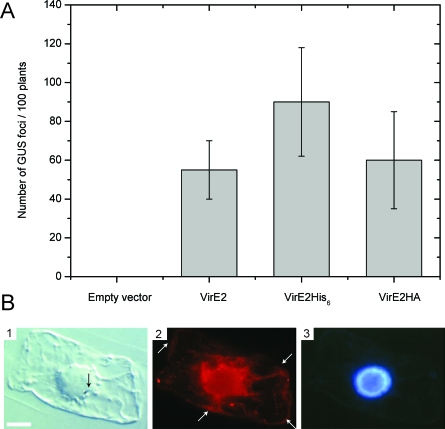
Localization of Active VirE2 Protein Transiently Expressed in Tobacco BY-2 cells(A) Tobacco plants were transformed with empty CAMBIA vector or CAMBIA vector allowing expression of VirE2, VirE2HA, or VirE2 His6. These transgenic plants were then used for transient T-DNA transfer assay. In this assay, the Agrobacterium strain lacking the virE2 gene was used to infect the plants and the VirE2 protein in the plant, if active complements the missing VirE2 activity of bacterium-origin. The T-DNA is also carrying a reporter gene which transfer can be detected by the appearance of blue spots (GUS) on plants. One can observe that all the VirE2 variants used in this study are active as they allow complementation of the Agrobacterium strain lacking the VirE2 gene.(B) (1) Tobacco BY-2 cell transformed by gold particles bombardment observed in Nomarski. The gold particle (located in the nucleus) is indicated by an arrow. The scale bar represents 10 μm. (2) Localization of VirE2. VirE2 is present around the nucleus, in cytoplasmic strands, representing a soluble, cytoplasmic pool of protein also visible at the cell periphery (white arrows) and in a few cytoplasmic spots. (3) DAPI staining of the nucleus of the transformed cell.